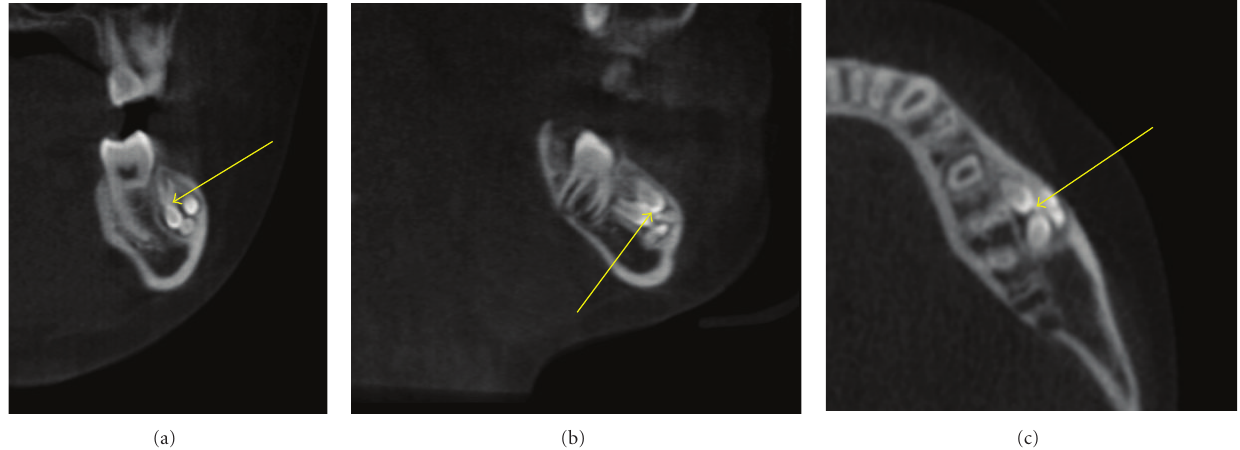
Figure 2: A Compound odontoma (arrows) made of multiple small tooth like entities seen in the facial aspect of the mandibular left second premolar and molar regions as seen in the mandible on these MPR images.